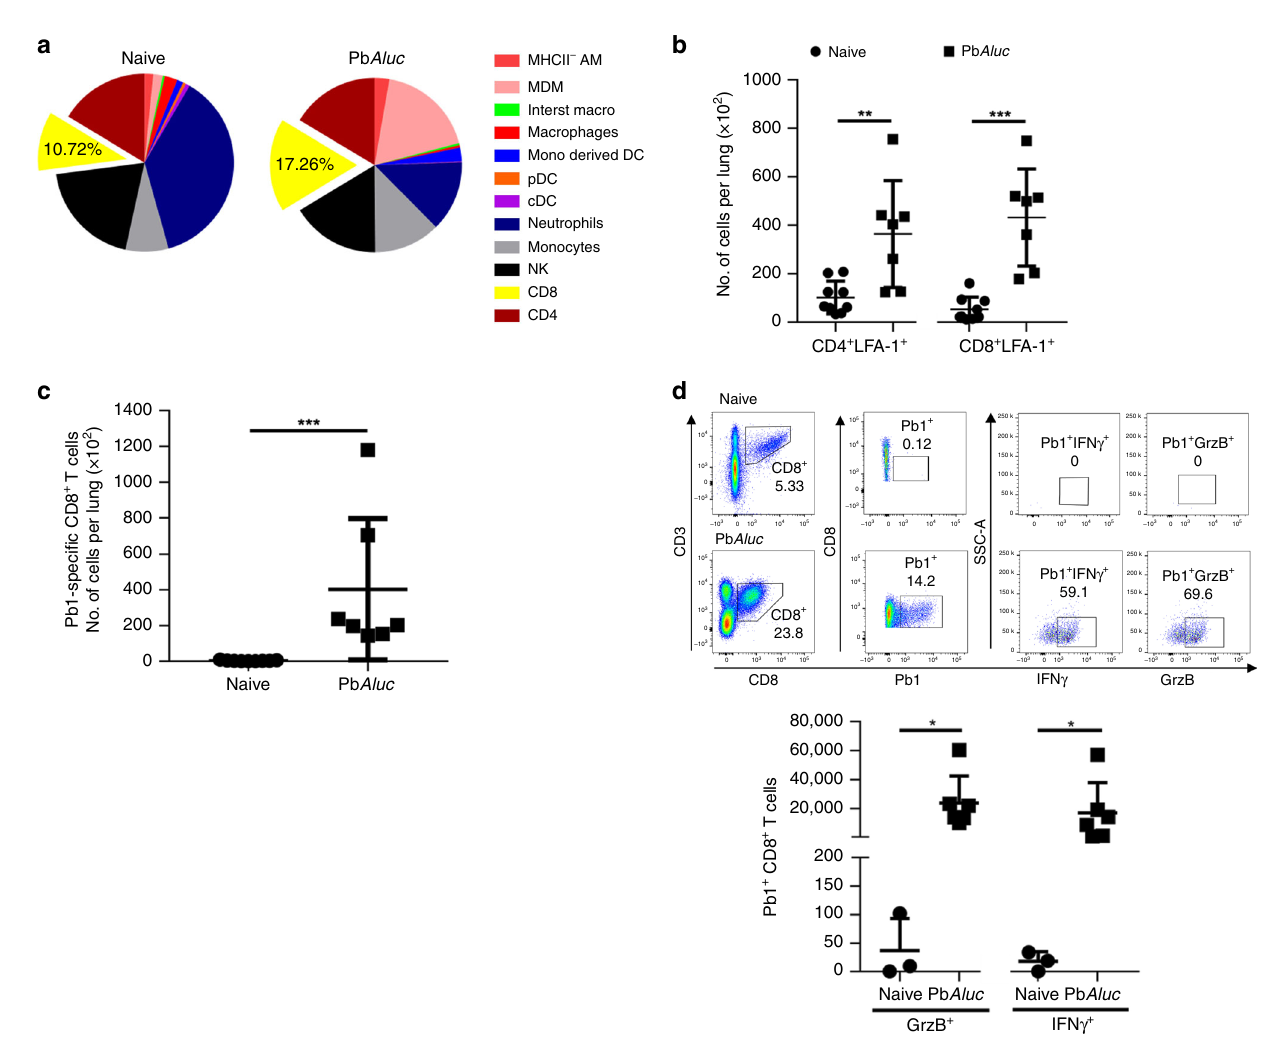
Fig. 2 In fl ammatory response induced in the lungs during PbA luc -infection in C57BL/6 mice. a Relative percentage of the mean counts of each immune-cell population found in the lungs of naive ( n = 9) and PbA luc -infected mice ( n = 11) at 7 dpi derived from the total number of cells shown in Supplementary Fig. 1. MHCII - AM MHC-Class II negative alveolar macrophages, MDM monocyte-derived macrophages, DC dendritic cell, cDC conventional dendritic cell, pDC plasmacytoid DC, NK natural killer. b Total number of CD4 + LFA-1 + and CD8 + LFA-1 + T cells and c Pb1-speci fi c CD8 + T cells accumulated in the lungs of naive ( n = 9) and infected mice ( n = 7). d Tetramer and intracellular cytokine staining was performed on lungs sequestered leukocytes from naive ( n = 3) and PbA luc -infected mice ( n = 6). Cells were incubated with Brefeldin for 3 h without re-stimulation. The indicated dot plot (top) was used to analyze the Pb1-speci fi c CD8 + T cells and to gate the IFN- γ + and GrzB + population. The total number of Pb1-speci fi c CD8 + T cells secreting each cytokine is represented graphically (bottom). The data shown are representative of two independent experiments. The data represent the mean ± SD; * p < 0.05, ** p < 0.01, *** p < 0.001 by Mann – Whitney test ( b – d